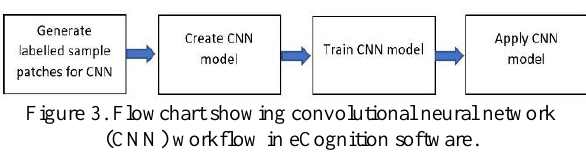
Figure 3. Flowchart showing convolutional neural network (CNN) workflow in eCognition